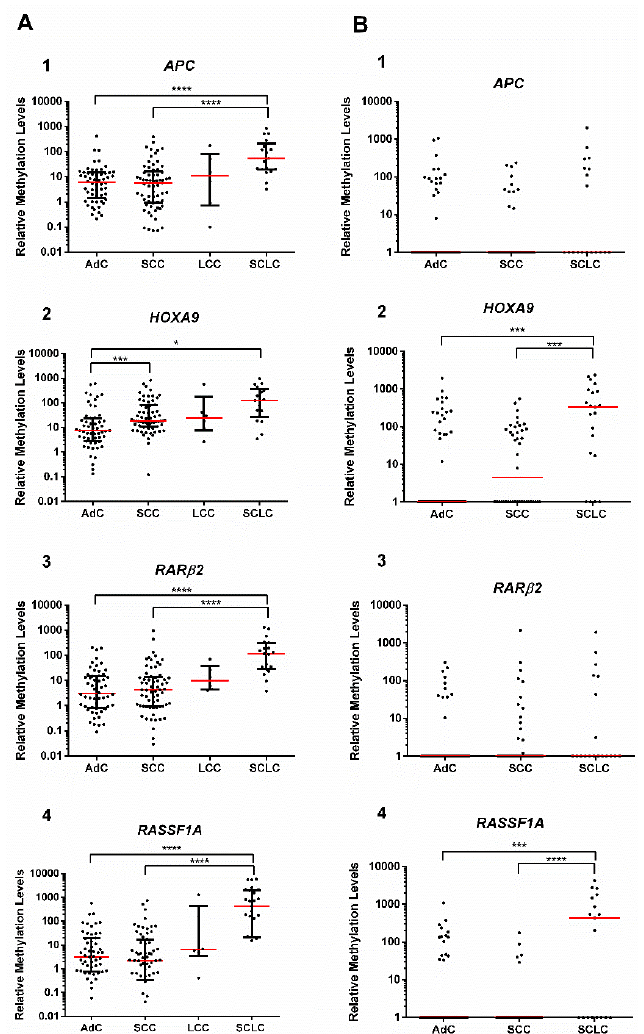
Figure 3. Scatter plot of ( A ) (1) APC , (2) HOXA9 , (3) RAR β 2, and (4) RASSF1A methylation level distributions among lung cancer (LCa) histological subtypes (adenocarcinoma (AdC), squamous cell carcinoma (SCC), large cell carcinoma (LCC), and small-cell lung cancer (SCLC)) in study group #1 (tissue samples) and ( B ) (1) APC (number of values that fall in the x axis: AdC = 48, SCC = 31, SCLC = 11), (2) HOXA9 (number of values that fall in the x axis: AdC = 44, SCC = 21, SCLC = 3), (3) RAR β 2 (number of values that fall in the x axis: AdC = 54, SCC = 27, SCLC = 12), and (4) RASSF1A (number of values that fall in the x axis: AdC = 50, SCC = 37, SCLC = 8) methylation level distributions among LCa histological subtypes (AdC, SCC, and SCLC) in study group #2 (plasma samples). Kruskal–Wallis test, followed by pairwise comparison though Mann–Whitney U and Bonferroni’s correction. * p < 0.05, ** p < 0.01, *** p < 0.001, and **** p < 0.0001. Red horizontal line represents the median methylation level.